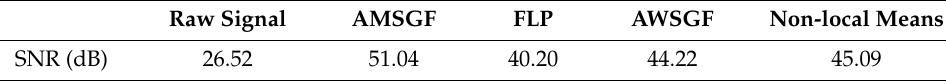
Table 3. SNR results of di ff erent smoothing